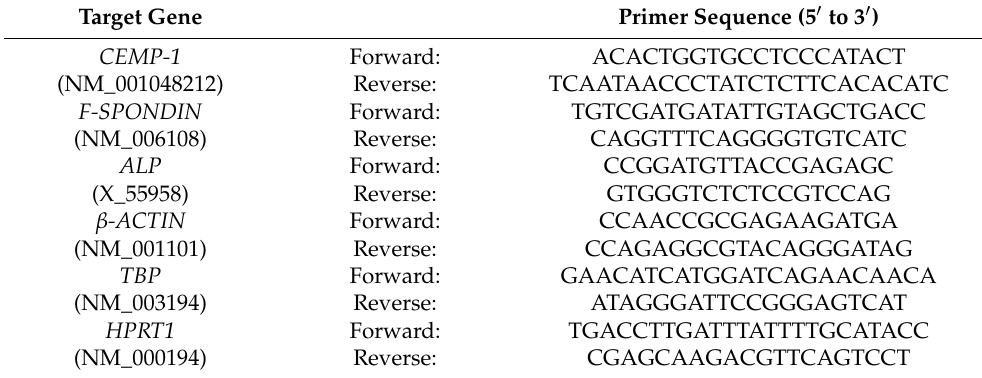
Table 2. The primers for real-time